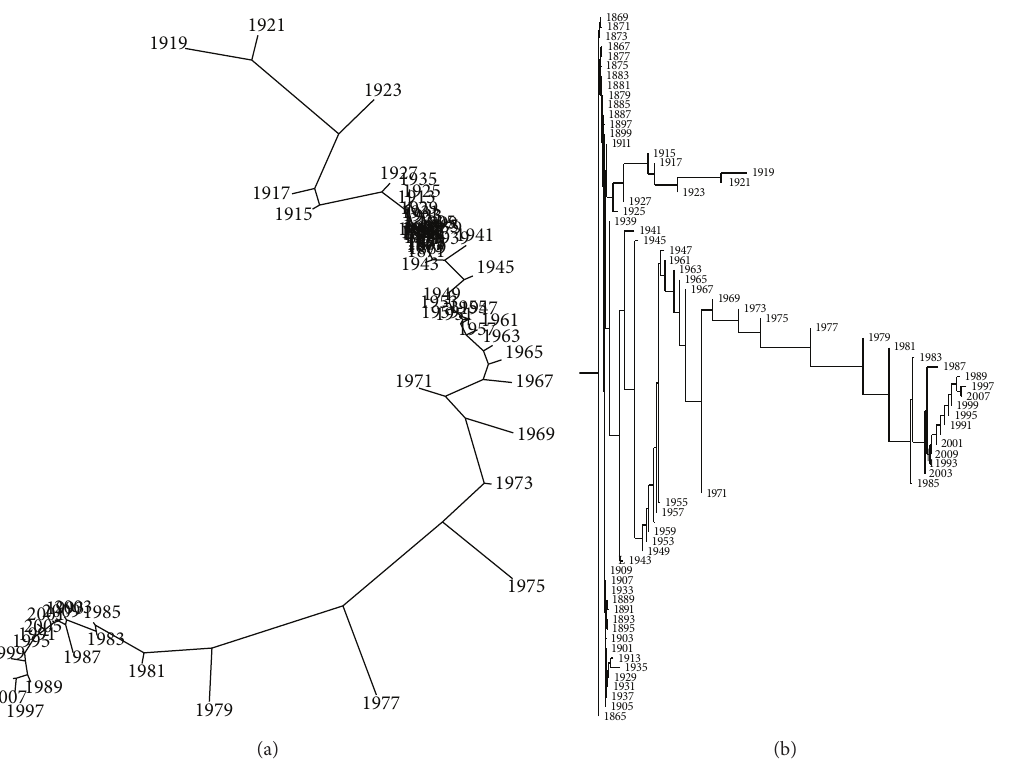
Figure 13: Trees of the Portuguese economic evolution, in the perspective of the Cosine correlation 𝑟 𝐶 , 𝑇 = 1865 – 2010 , ℎ = 2 years, method “neighbor”, (options “drawtree” and